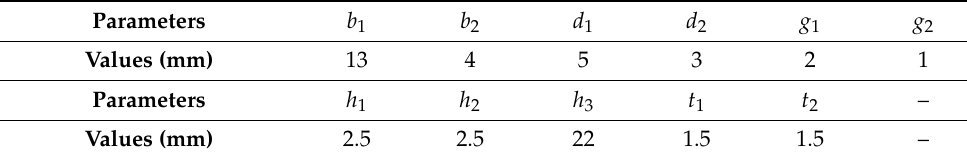
Table 1. Parameters of the newly proposed soft pneumatic actuator.